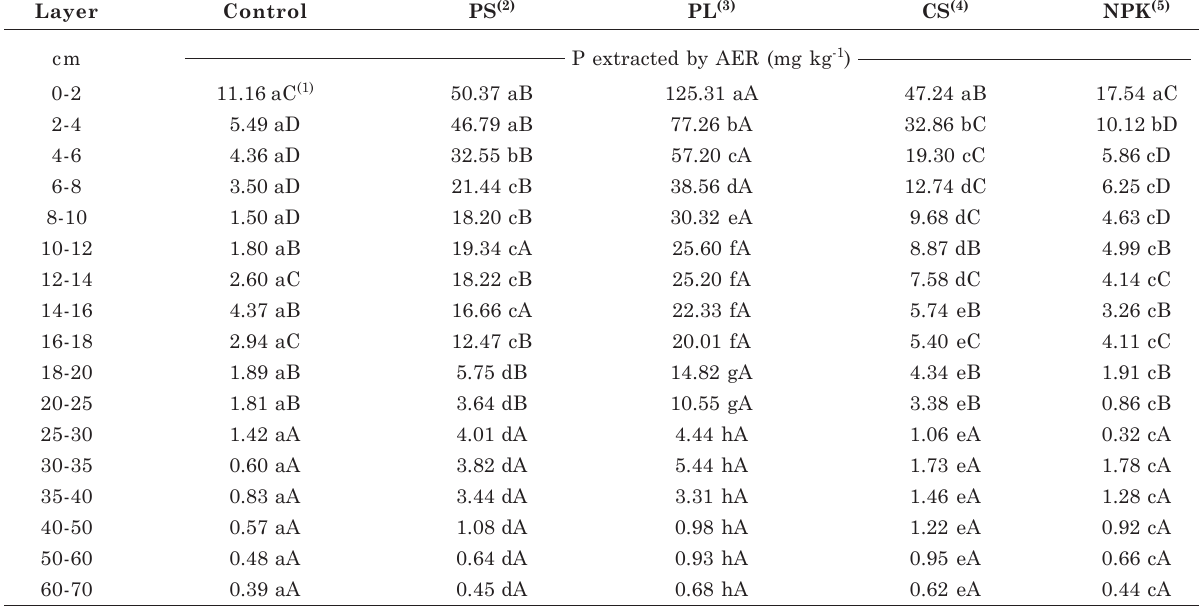
Table 2. Phosphorus contents extracted by anion exchange resin (AER) in layers of a Typic Hapludalf subjected to applications of nutrient sources under a no-tillage system in November 2008, four years after experimental